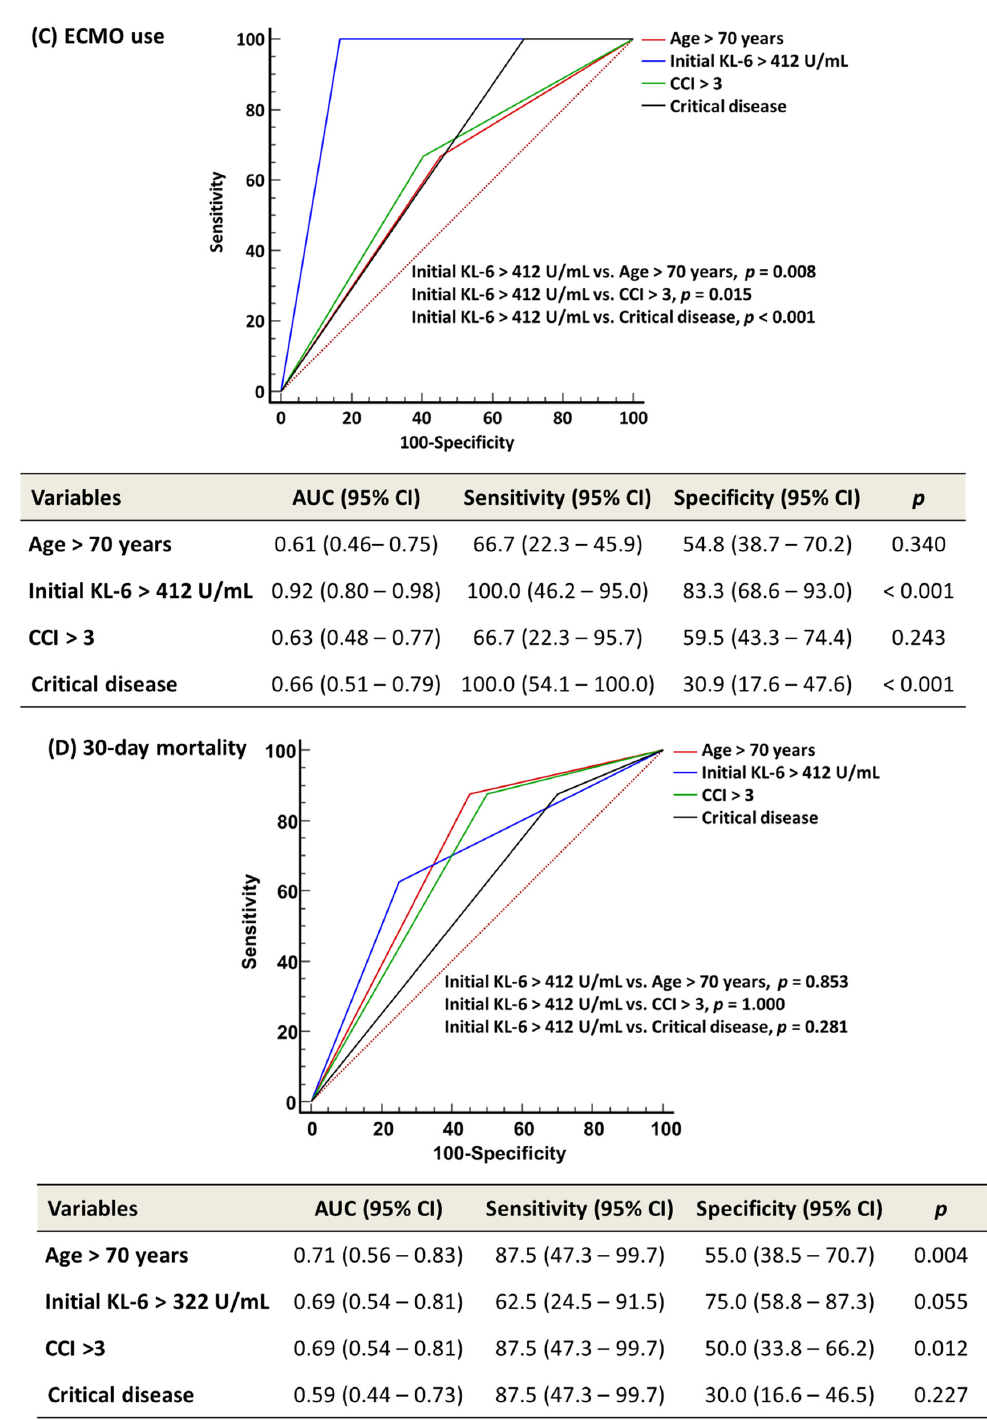
Figure 3. The ROC curve analysis of age, initial KL-6 level, CCI, and critical disease to predict clinical outcomes. In all variables except initial KL-6 level, the optimal cut-off values for 30-day mortality were applied. In initial KL-6, the respective optimal cut-off values were applied; 412 U/mL for ICU admission, ventilator use, and ECMO use and 322 U/mL for 30-day mortality. ( A ) ICU admission. ( B ) Ventilator use. ( C ) ECMO use. ( D ) 30-day mortality. Abbreviations: ROC; receivers operating characteristic; KL-6, Krebs von den Lungen-6; CCI, Charlson comorbidity index; ICU, intensive care unit; ECMO, extracorporeal membrane oxygenation; AUC, area under the curve; and CI, confidence